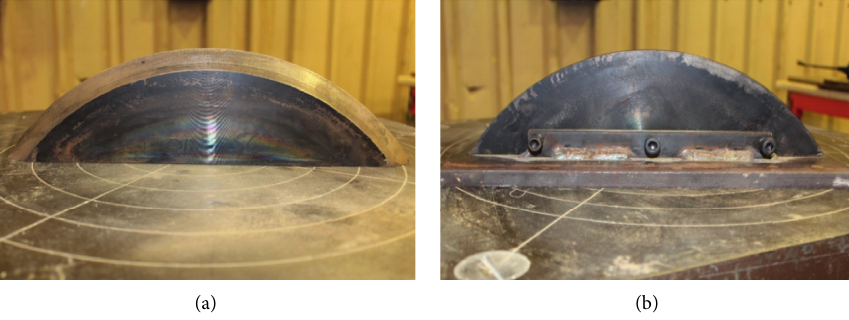
Figure 3: Fabricated cutters: the V shape one (a) and CCS one (b).